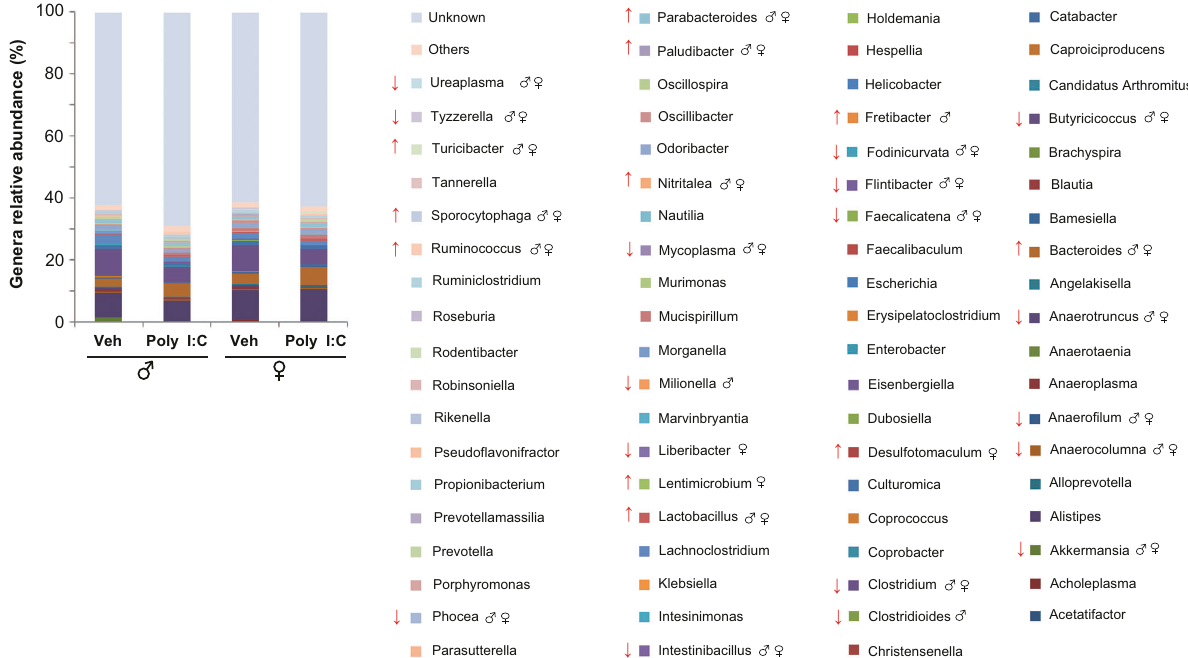
Fig. 5 Microbiota changes induced by MIA in male and female offspring at pnd 28. Mean relative abundance (%) of gut bacteria at genera level; ↑ signi fi cant increase, ↓ signi fi cant decrease. Two-way ANOVA with post-hoc Tukey ’ s observe any changes in anxiety-like behavior measured through the assessment of the time spent in the center of OF arena and open-arms of EPM, according to [34]. Additionally, Poly I:C offspring displayed decreased PPI as reported by previous studies [26, 38] and in agreement with the sensorimotor gating de fi cits in ASD children described in a recent meta-analysis [39]. Both sexes were comparably affected by the early immune challenge, though males seemed more impaired than females. However, this trend was not statistically signi fi cant except for perseverative behavior, more prominent in Poly I:C males. We evidenced relevant sex-related differences in the neu- roin fl ammatory response triggered by MIA in the hippocampus and cerebellum, two brain regions consistently implicated in ASD [29, 40 – 42]. Different neuroin fl ammatory pro fi les were evident in males and females depending on age and brain region considered. A prominent induction of the pro- in fl ammatory factors TNF- α , IL-6, and iNOS, were observed in Poly I:C females only. Consistently, sex differences in neuroin- fl ammatory pro fi le in the hippocampus have been documented in adult MIA offspring [43]. MIA affected also Arg-1 and BDNF expression in the hippocampus of offspring of both sexes at adolescence but these alterations were attenuated at later stages of development. Dysregulation of BDNF and its relative signaling pathway has been involved in ASD phenotype [44, 45], as well as in altered developmental pruning in multiple brain regions [46, 47]. An interesting fi nding concerns the regulation of ARG-1, which increased in the hippocampus of MIA offspring in adolescence but signi fi cantly decreased in adulthood; the latter is in agreement with decreased ARG-1 expression reported in the hippocampus and prefrontal cortex of offspring prenatally exposed to Poly I:C [48] or LPS [49], respectively. ARG-1 is an alternative microglial activation marker, which competes with iNOS for the substrate L-arginine and inhibits the production of nitric oxide (NO), thus participating to the resolution of in fl ammation [50]. Besides this role, ARG-1 plays a critical role in